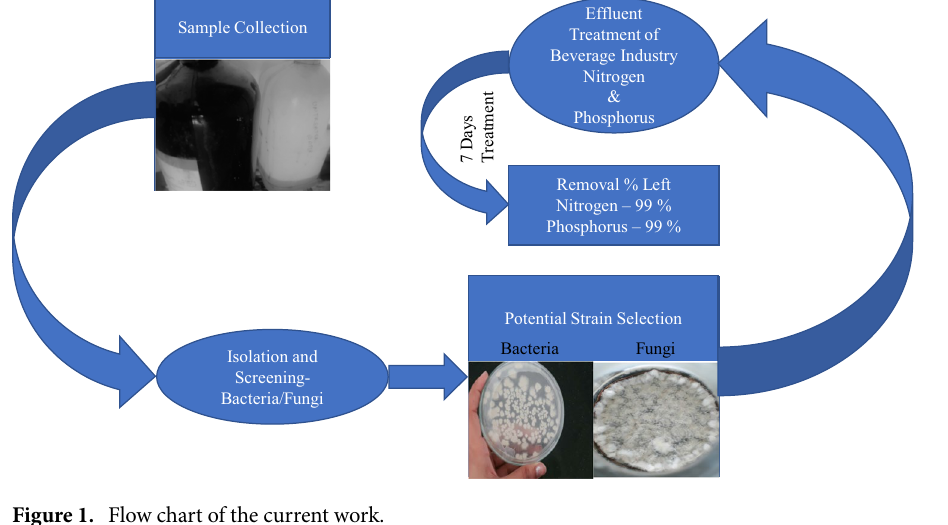
Figure 1. Flow chart of the current